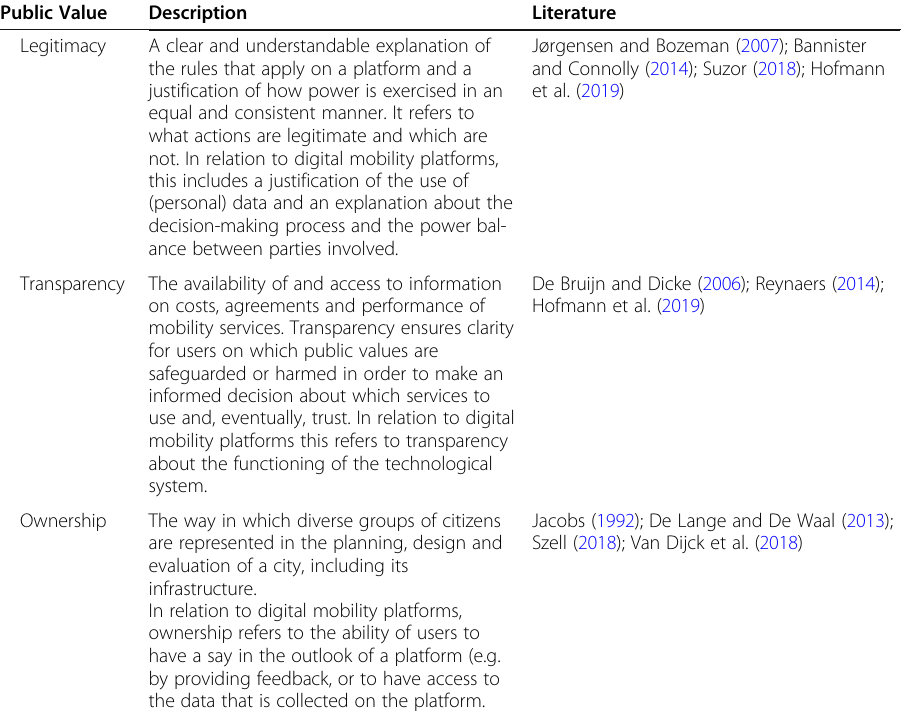
Table 3 The assessment framework with the four theoretical dimensions, value descriptions and literature references